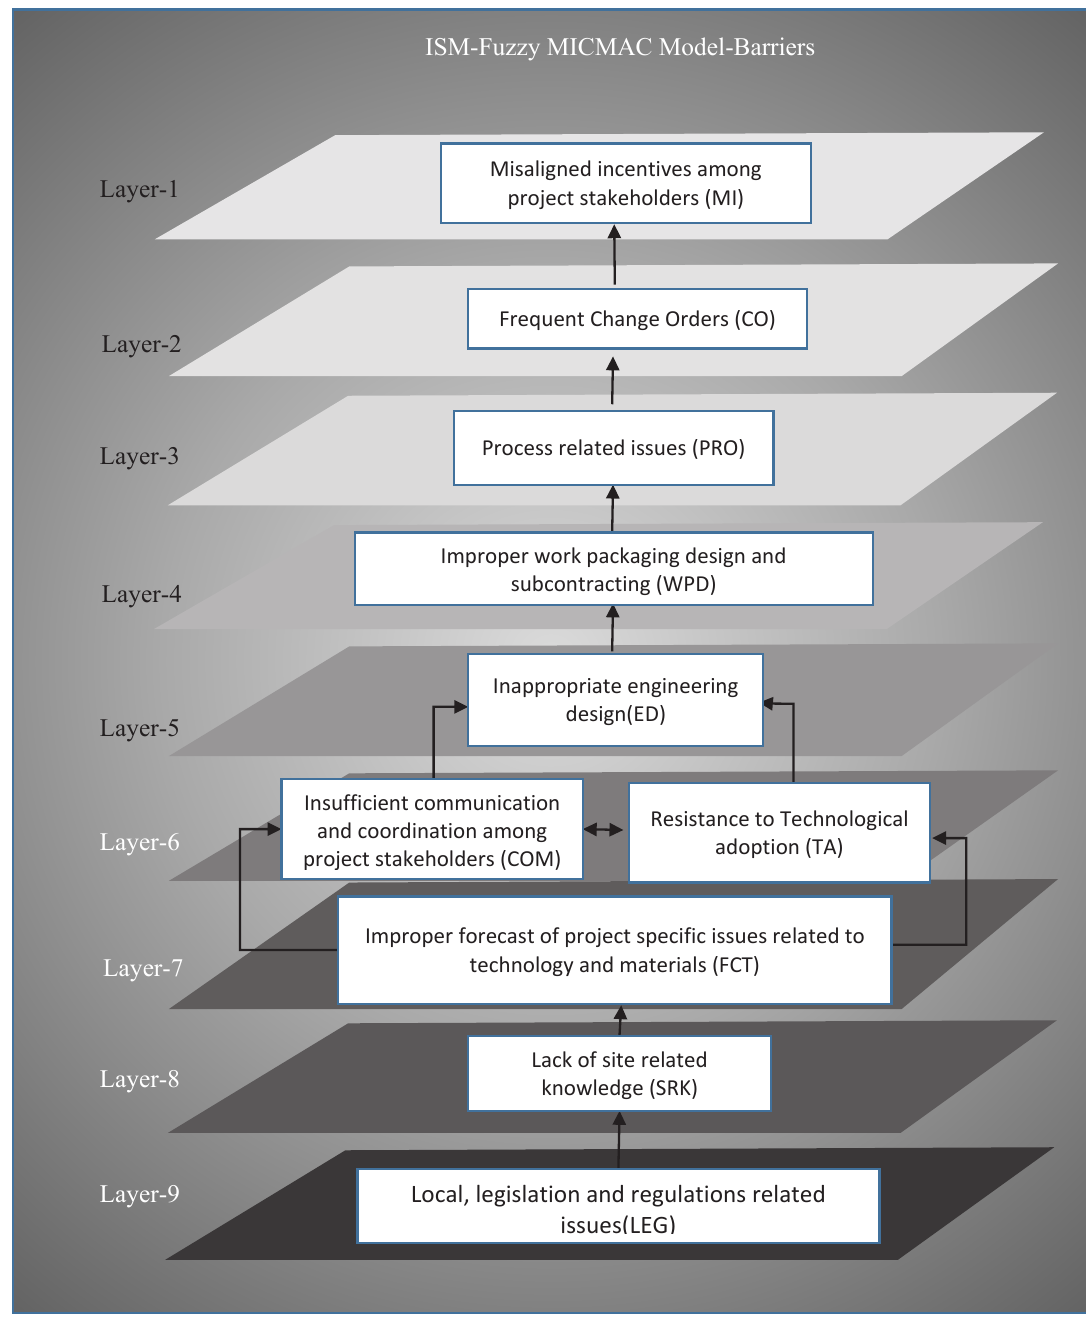
Figure 3. ISM Fuzzy MICMAC Model for Barriers to